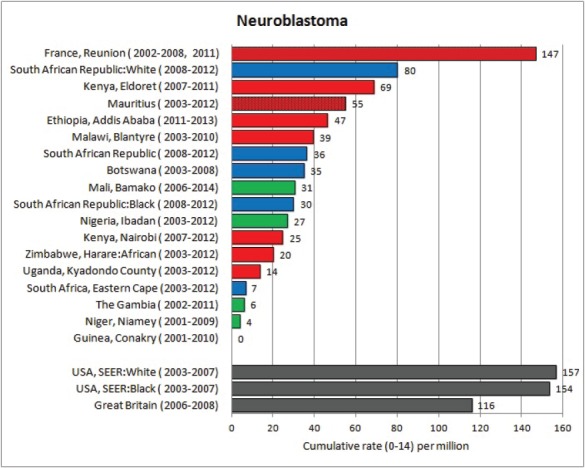
Cumulative (0–14) incidence rate – neuroblastoma.